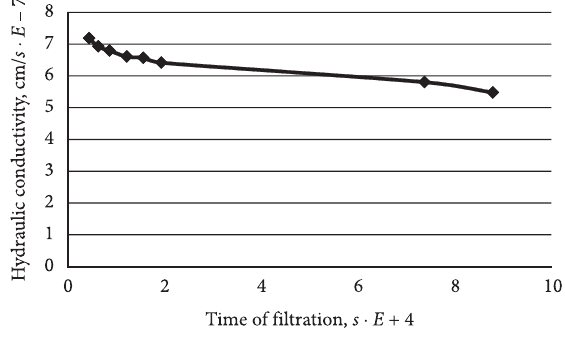
Fig. 8. Variations of hydraulic conductivity in time during the third stage of filtering after the second freeze-thaw